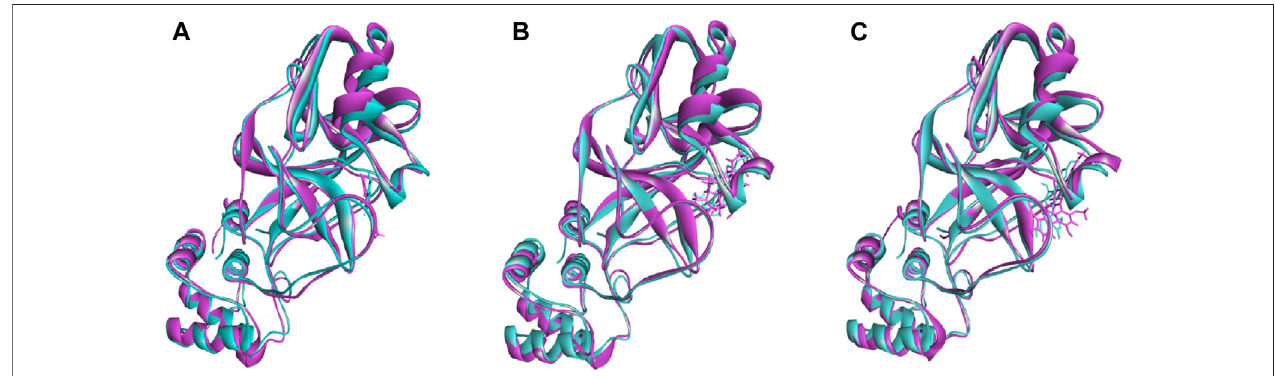
FIGURE7| Thesurfaceviewofthedockedcomplexduringthemoleculardynamicssimulation.Snapshots weretakenat25,50,75,and100 nsforthemedicagol and M pro complex. The binding pose and positions of the ligands were remained rigid in different simulation time intervals.